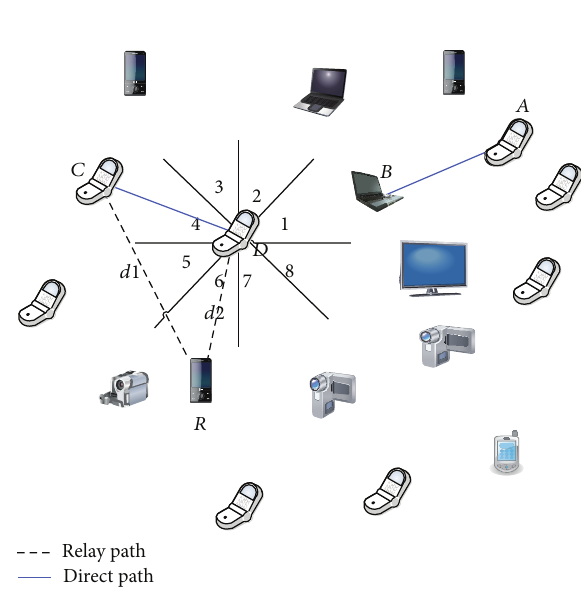
Figure 3: Intragroup multihop